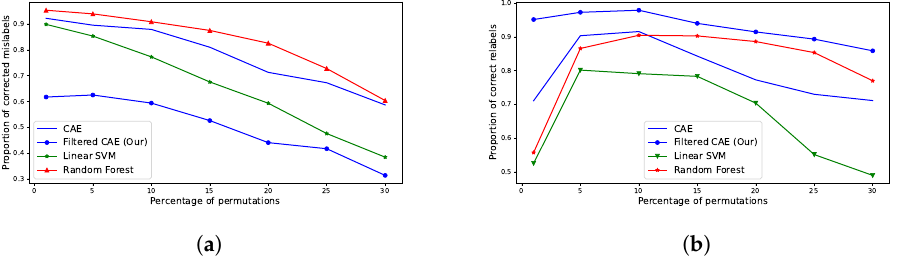
Figure 12. Performance measurements and comparison between our methodology and others (Vanilla CAE, Random Forests, Linear SVM). ( a ) Amount of corrected mislabels (eq. to recall measurement). ( b ) Amount of correct relabels (eq. to precision measurement). Table 4. Performance comparison between methodologies. (Best performance highlighted in